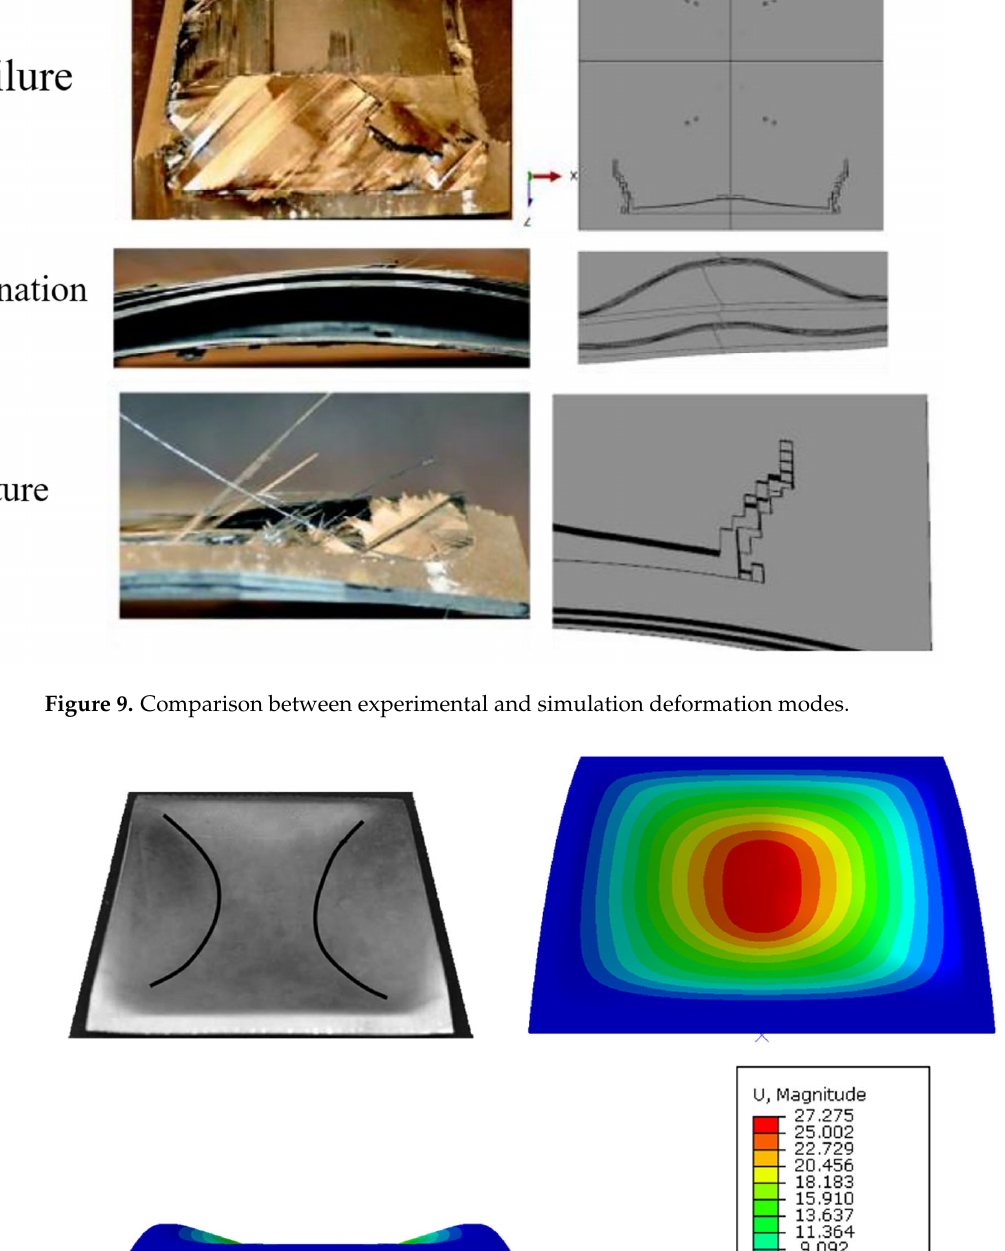
Figure 11. Comparison between the experimental and numerical predicted maximum central de- flection of aluminum panel.